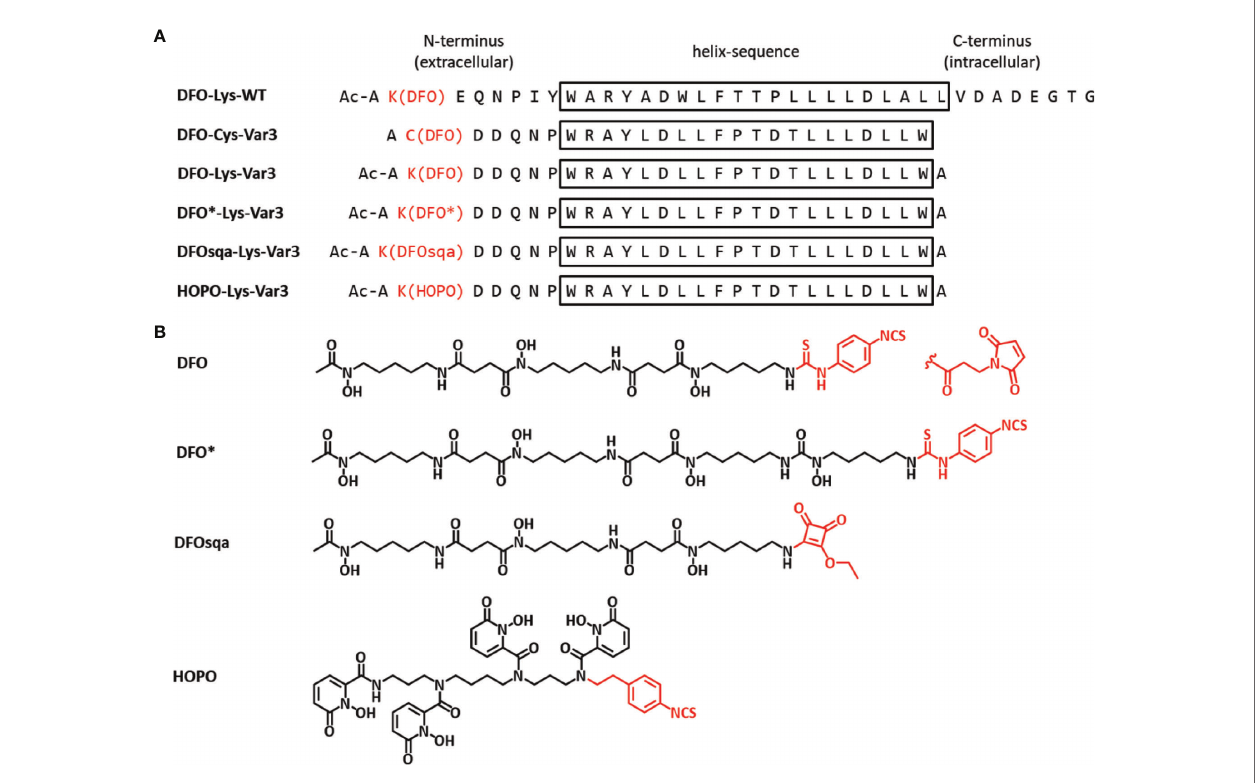
FIGURE 2 | (A) The pHLIP sequences (d-amino acids) of the six investigated constructs in single letter code and (B) the chemical structures of the four chelators (active conjugation side in red). The conjugation was either performed by reacting the Lys-pHLIP with the isothiocyanate version of the chelator (activated ethyl ester for DFOsqa) or reacting the Cys-pHLIP with